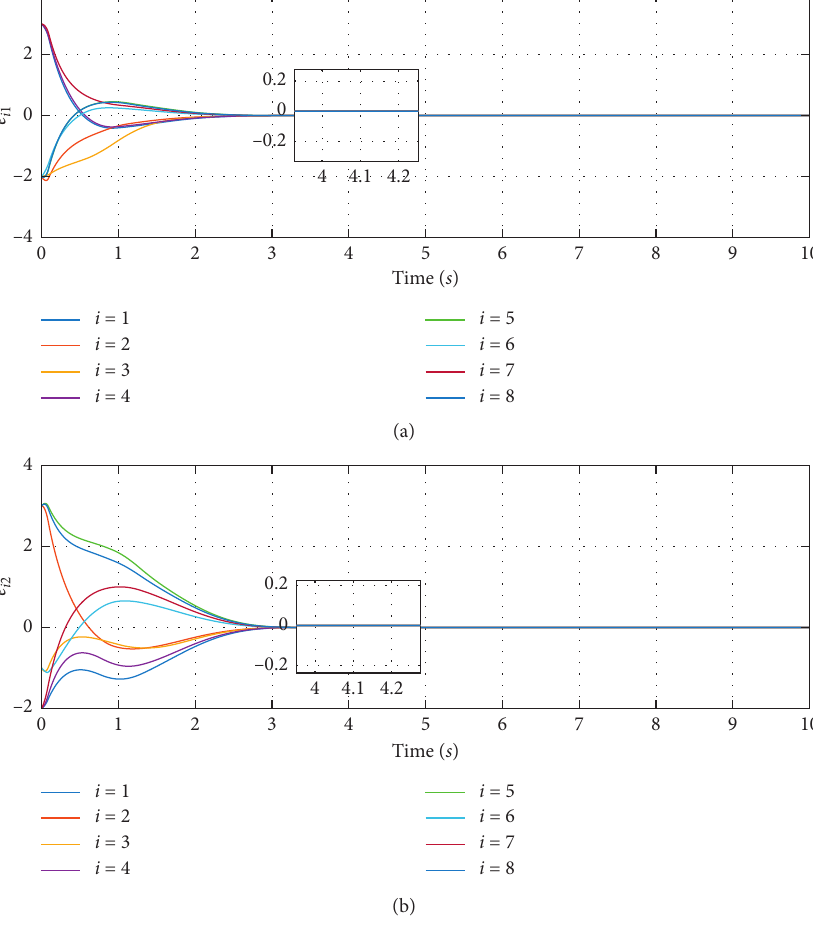
Figure 6: Pictures (a) and (b) reveal the evolution of the position tracking errors for links 1 and